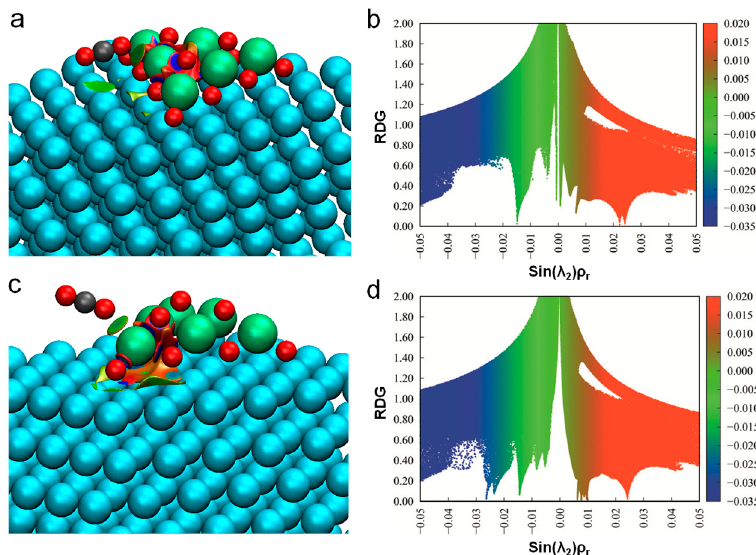
Figure 3. ( a ) Gradient isosurfaces for CO 2 *(Ce 3+ ), ( b ) Scatter plot of RDG and sign( λ 2 )/ ρ for CO 2 *(Ce 3+ ), ( c ) Gradient isosurfaces for CO 2 *(Ce 4+ ), ( d ) Scatter plot of RDG and sign( λ 2 )/ ρ for CO 2 *(Ce 4+ ). The surfaces are colored on a blue-green-red scale according to values of sign( λ 2 )/ ρ , ranging from − 0.05 to 0.05 au. Blue indicates strong attractive interactions, green indicates Van Der Waals interactions and red indicates strong nonbonded overlap.